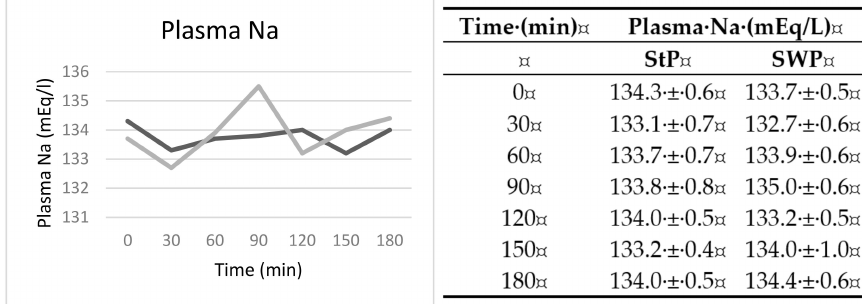
Figure 5. Plasma sodium (mEq / L) expressed as mean ± standard error of the mean (SEM) of the 12 participants from the beginning of the test for 3 h, every 30 min. StP: standard pizza. SWP: seawater pizza. Dark grey: standard pizza. Light grey: seawater